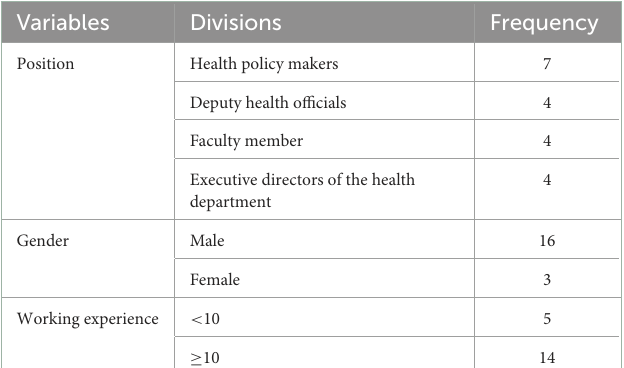
TABLE 1 Participants